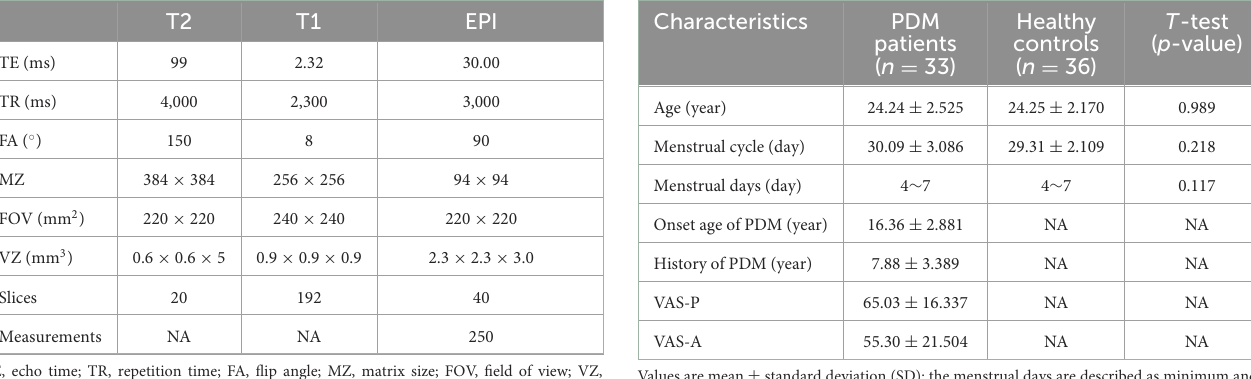
TABLE 1 Parameters of magnetic resonance scanning. TABLE 2 Demographic and clinical characteristics of